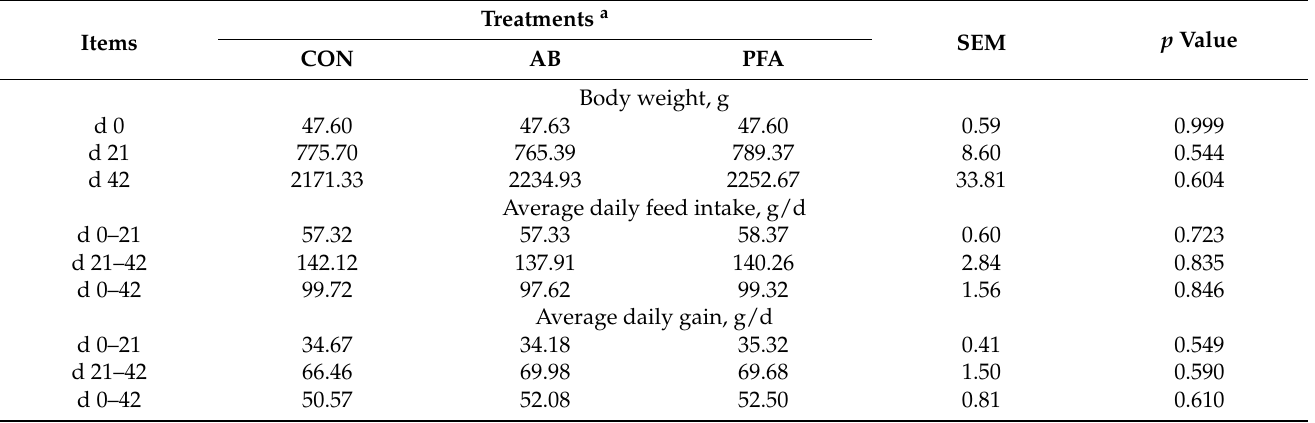
Table 3. Effects of paraformic acid (PFA) supplementation on growth performance of